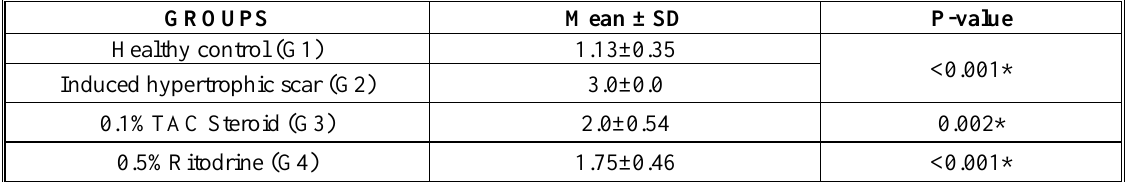
Table1. Mean TGF-β1 scores in control and study groups: GROUPS